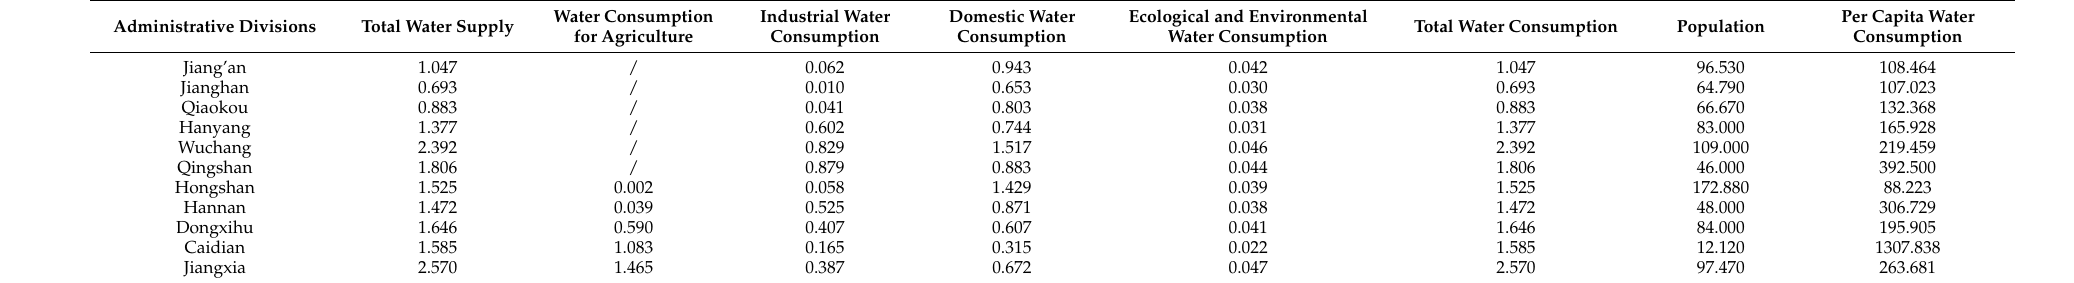
Table 3. Water consumption in Wuhan (100 million cubic